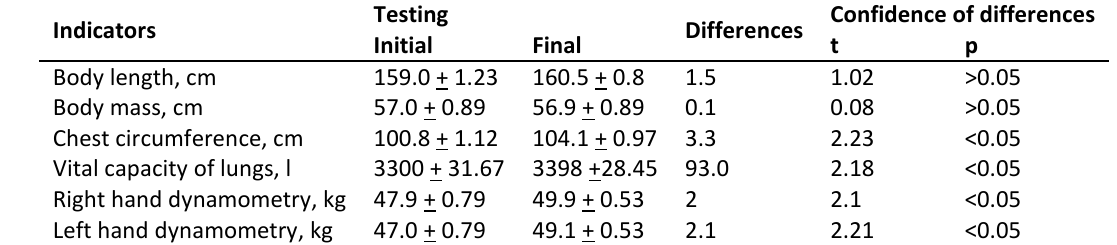
Table 2. Indicators of students’ physical metric parameters at the beginning and at the end of pedagogic experiment (M+m) Indicators